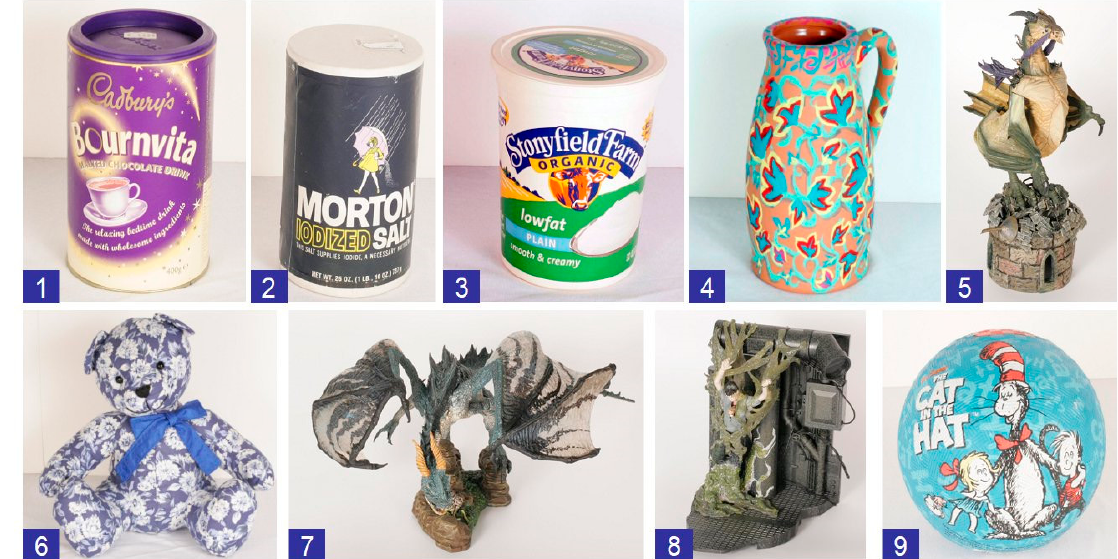
Figure 10. The indoor image set.